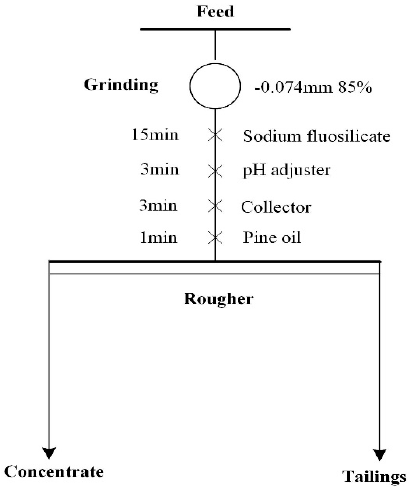
Figure 1. Flow sheet of flotation tests.